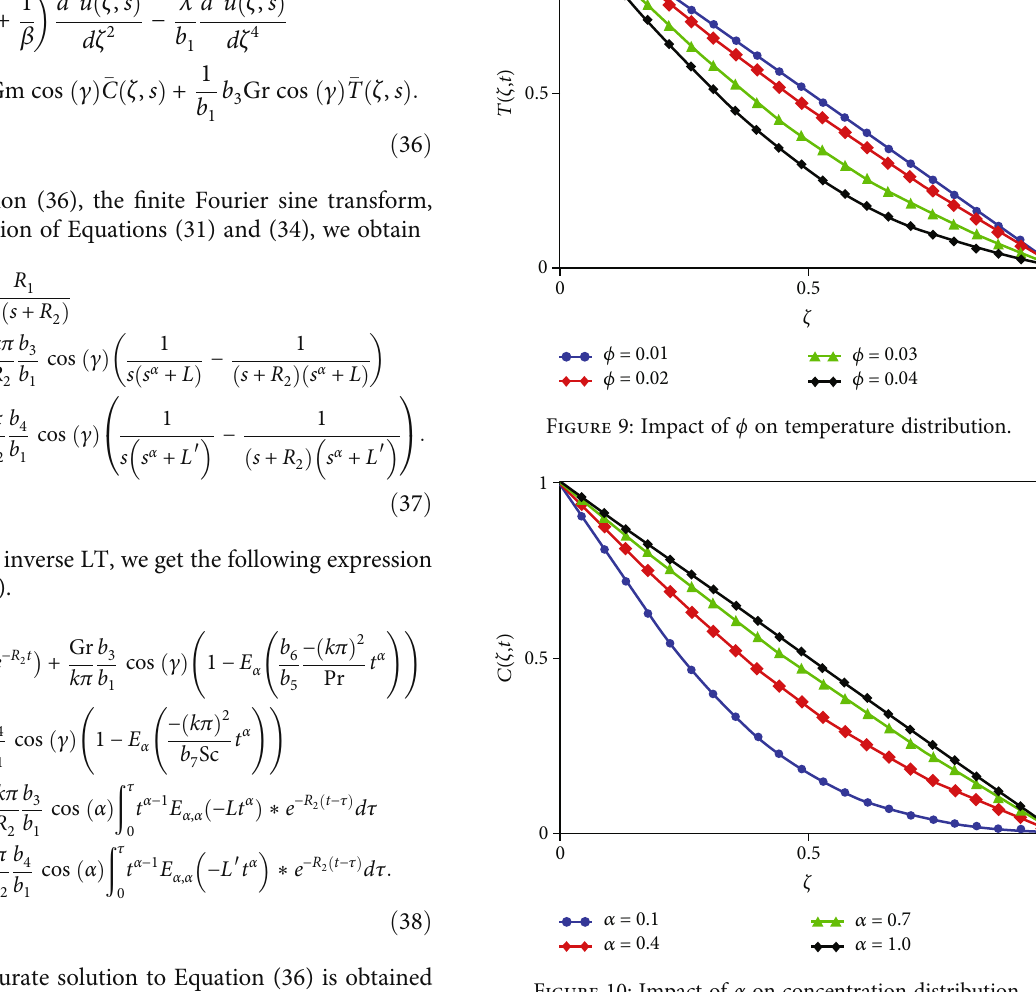
Figure 10: Impact of α on concentration